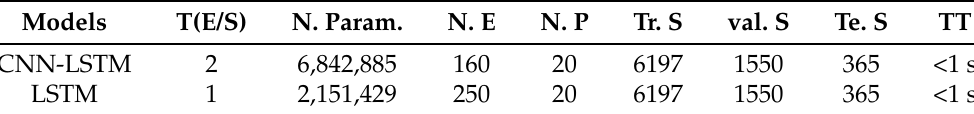
Table 9. Computation efficiency of the LSTM and CNN-LSTM models.